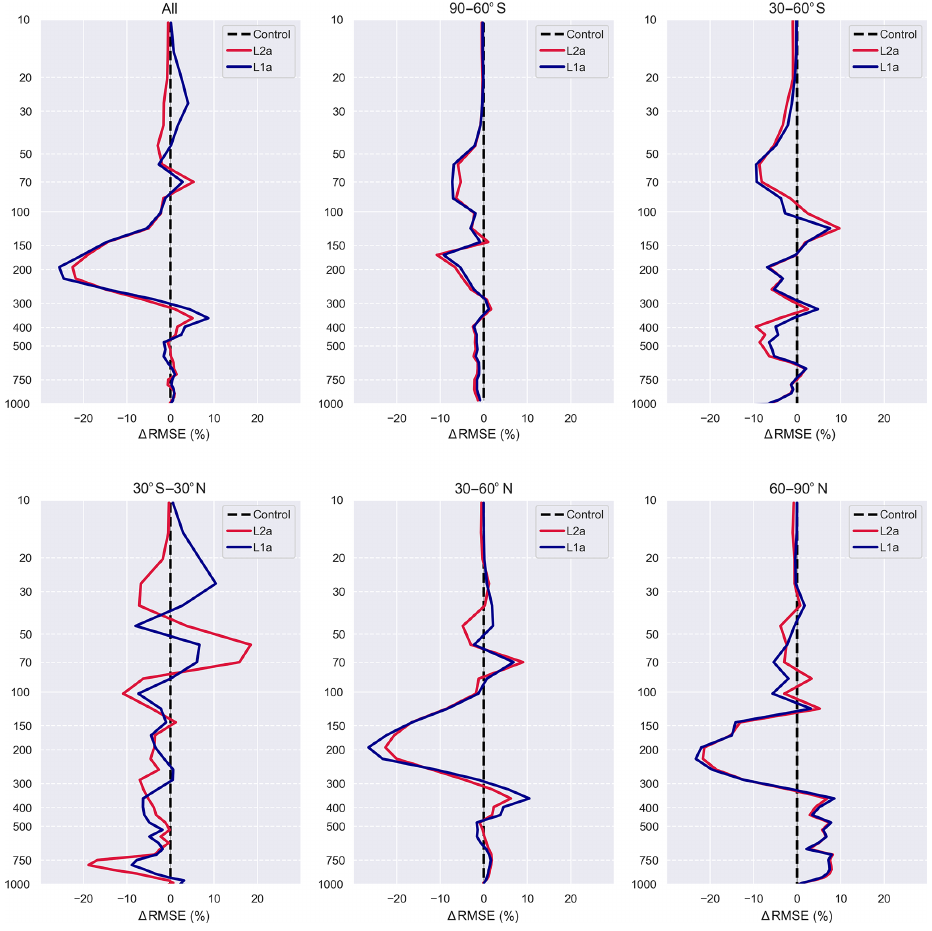
Figure 9. Relative difference of RMSE ( (cid:49) RMSE) with respect to radiosoundings for L1a (blue) and L2a (red). The difference is computed by subtracting the RMSE of L1a (L2a) from the RMSE of the control simulation (Fig. 3). Negative values mean that the assimilation improved (decreased) the RMSE of the control simulation, and positive values indicate degradation (increase) of the RMSE. The statistics are computed for the same latitudes as in Fig.